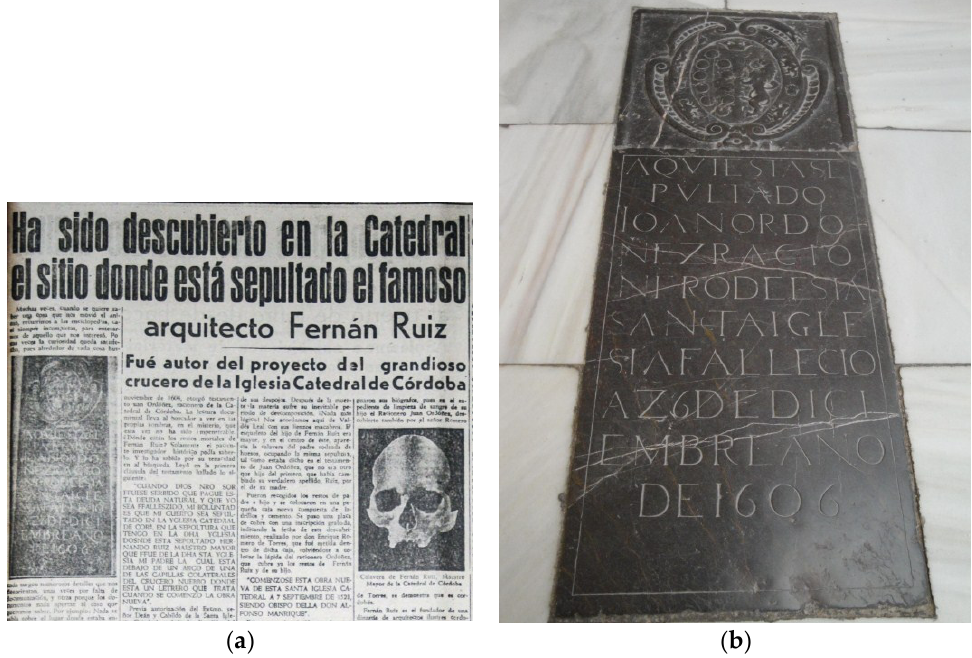
Figure 16. Juan Ordoñez and Hernan Ruiz I’s burial. Mezquita-Catedral (Cordoba): ( a ) piece of news; ( b ) tomb. Photo took by author.